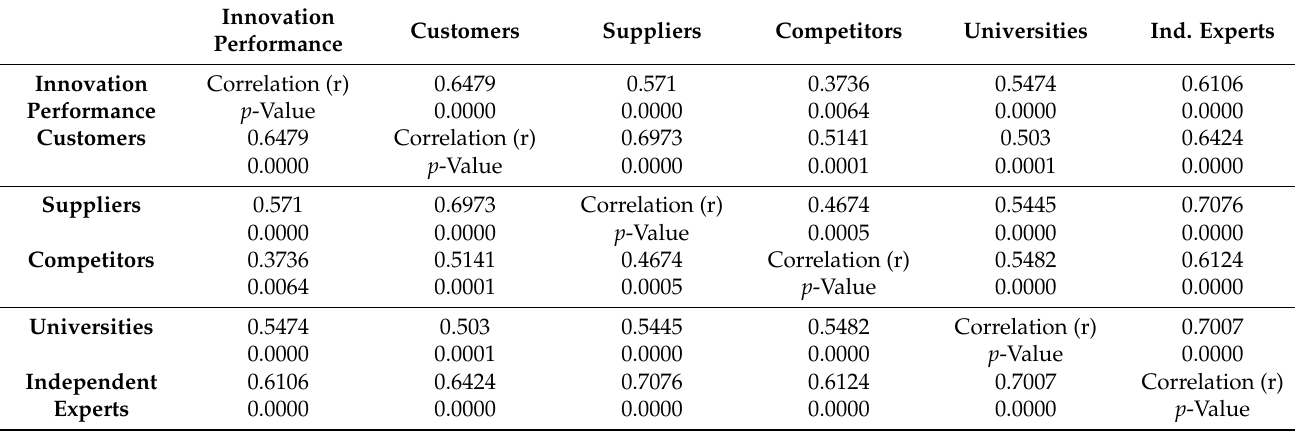
Table 7. Pearson’s correlations between innovation performance and collaboration with various external partners.